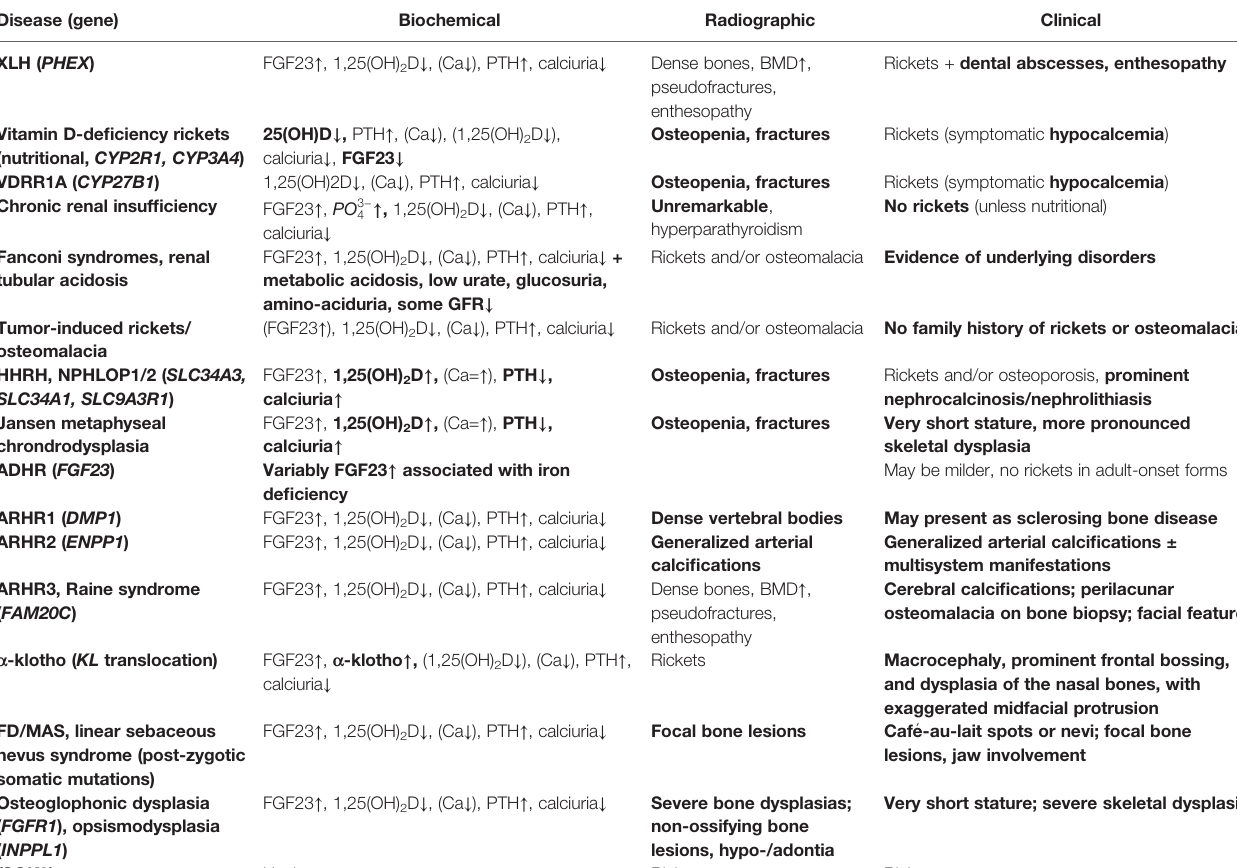
TABLE 1 | Differential diagnoses of X-linked hypophosphatemia